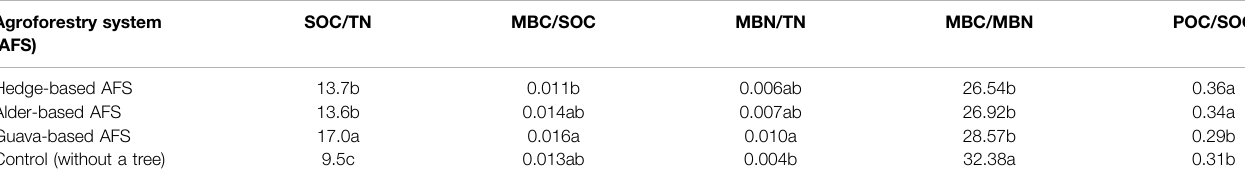
TABLE 3 | Ratios of soil organic matter forms.